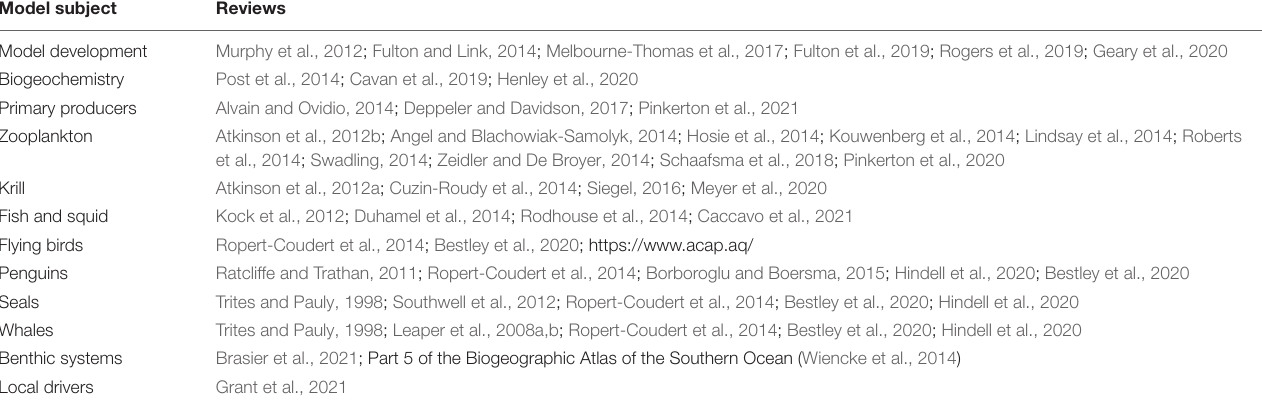
TABLE 1 | Summary of review papers that inform modelling of Southern Ocean food webs and